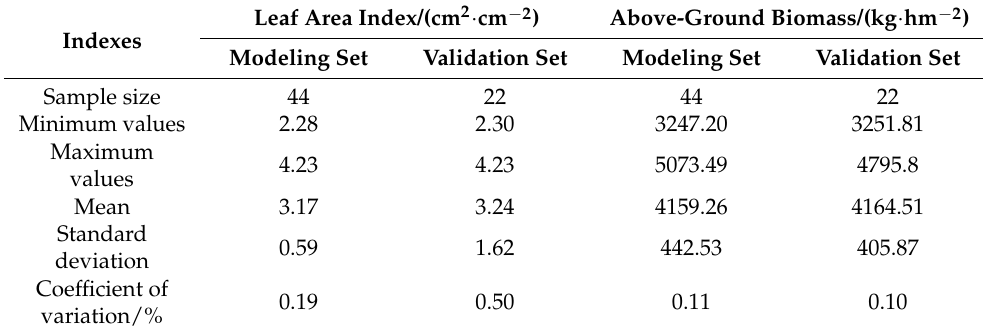
Table 1. Statistics of leaf area index and above-ground biomass in summer maize vegetation growth